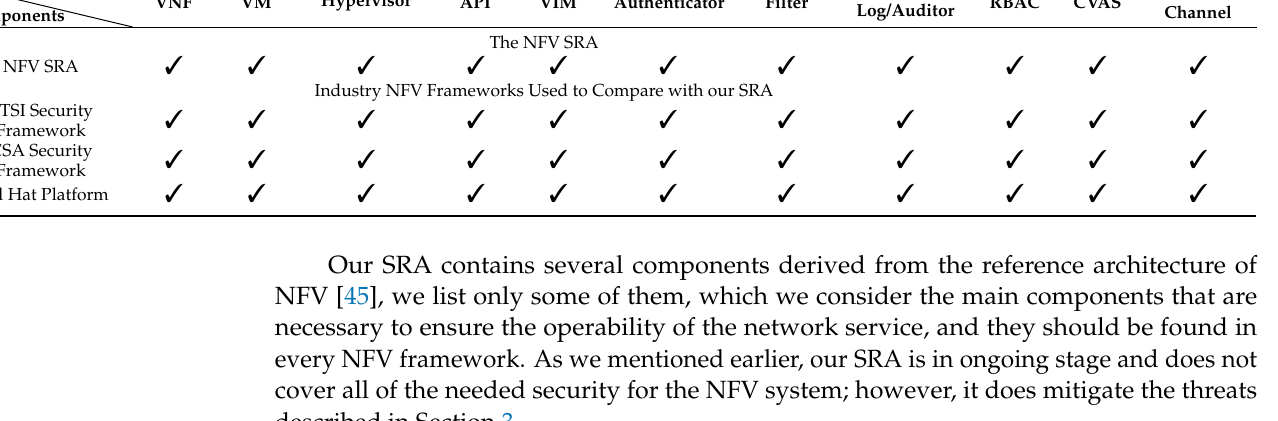
Table 3. Validation of the Security Reference Architecture of NFV . Components